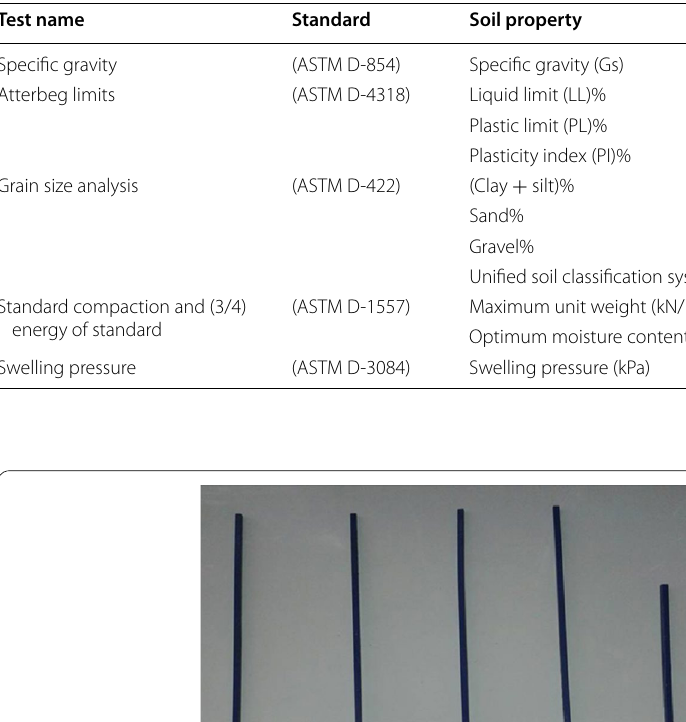
Table 1 Physical properties of expansive soil